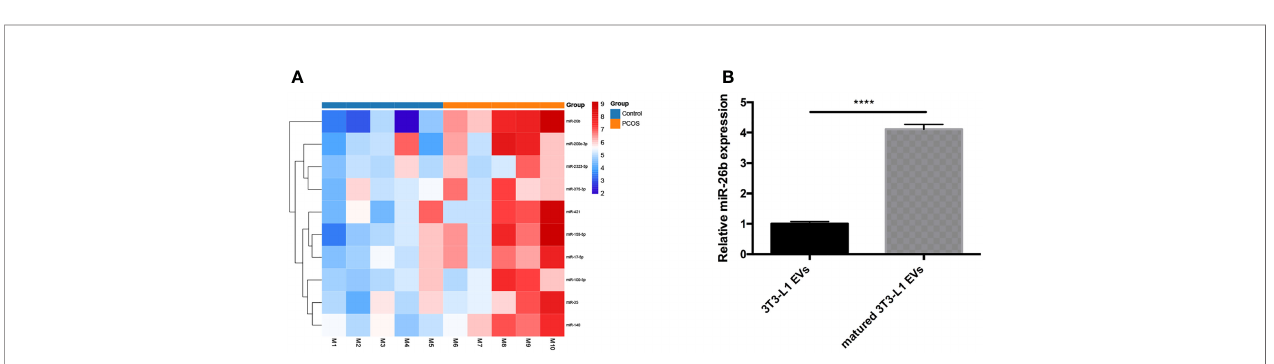
FIGURE 6 | Analysis of differentially expressed extracellular vesicles miRNAs isolated from serum in diverse groups. (A) Heat map of differentially expressed miRNAs in the two groups. (B) Veri fi cation of miR-26b in the extracellular vesicles derived from pre-adipocytes and mature adipocytes; ****p <